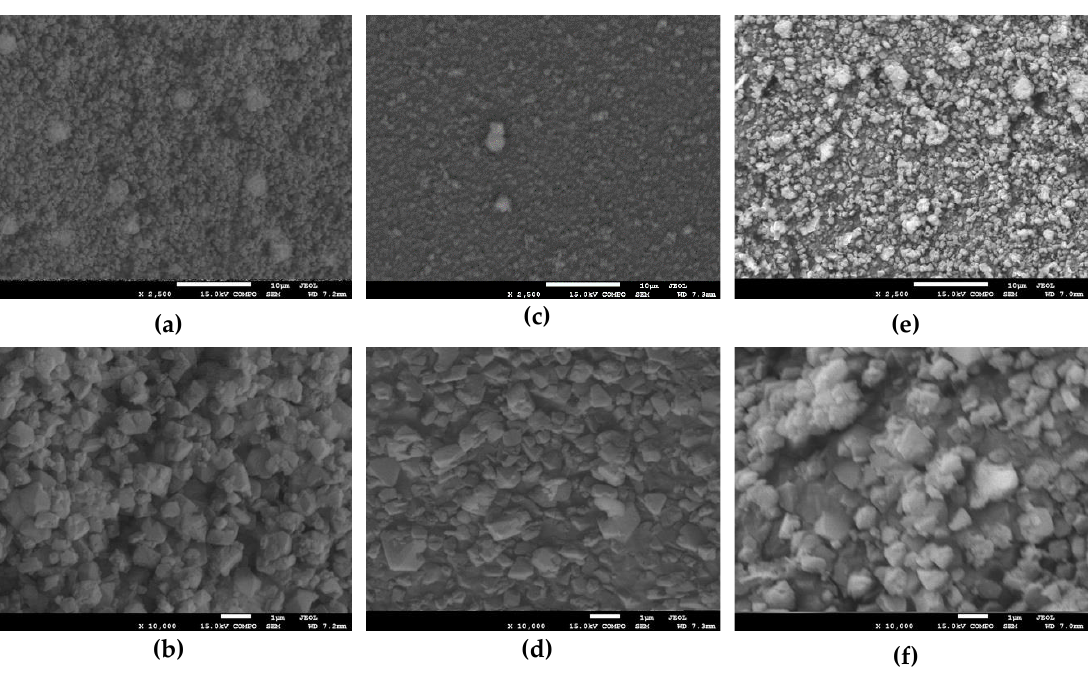
Table 1. Results of the X-ray fluorescence (XRF) analysis of the studied vanadium catalysts. FAU: faujasite and FAUdes: desilicated FAU. Sample